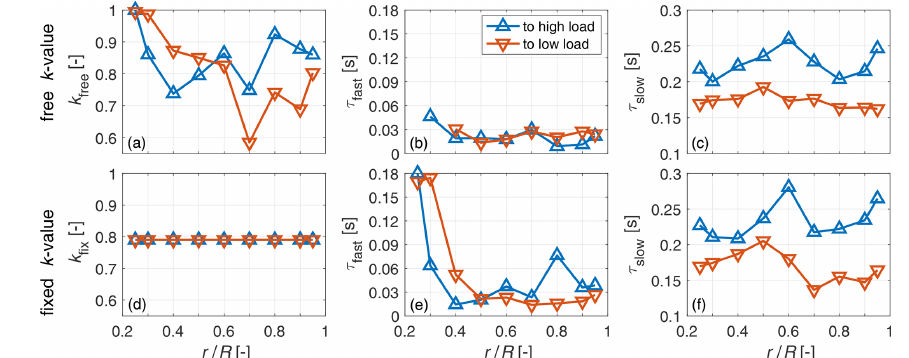
Figure 11. Two-time-constant model fit to the axial wake induction factor, derived from the rotor plane LDA measurements with the ratio k and the fast τ fast and slow τ slow time constants. In the top row the k value is fitted as a free parameter. In the bottom row the weighting ratio of fast and slow time constant k is fixed (to the mean value of both pitch directions and radii of the fit in the top row).